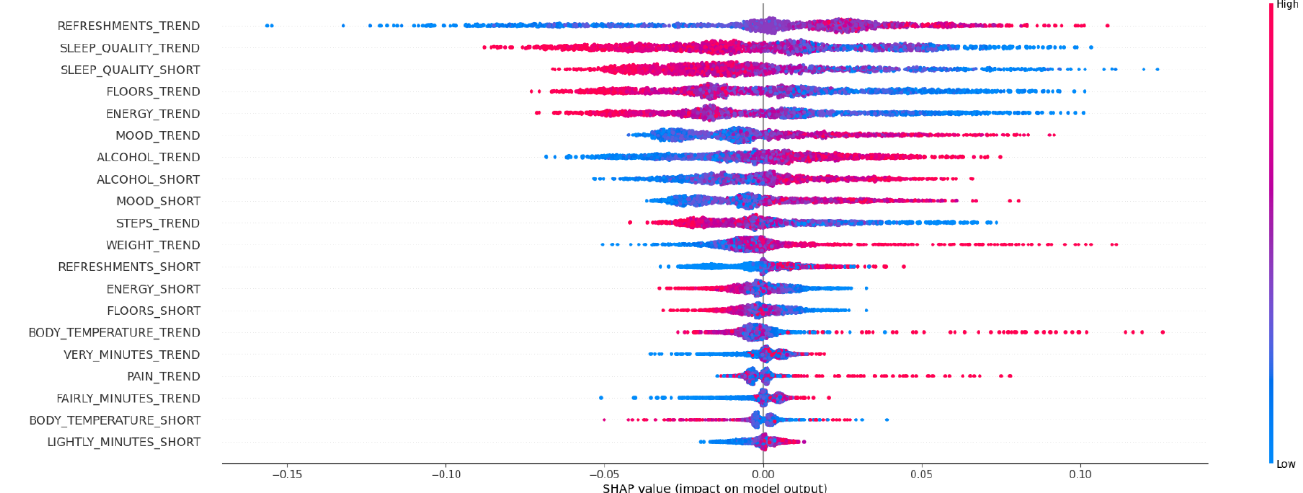
Figure 10. Shapley additive explanations (SHAP) analysis of the individual feature vectors, signaling the importance of small, medium and large feature values in the final decision reached for this vector.